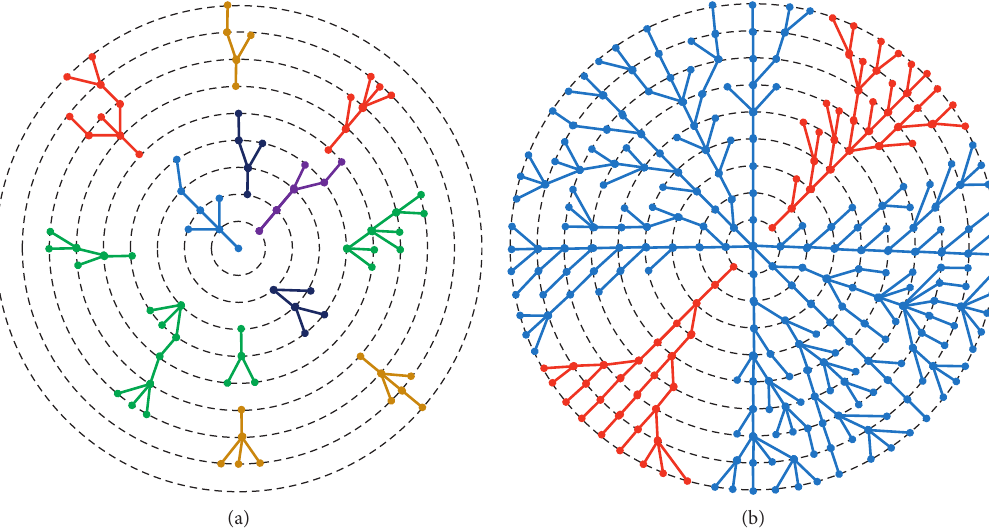
Figure 7: Hierarchical organizational structure of Twitter retweet distribution, corresponding to chaotic and ordered phases. (a) Subcritical phase. (b) Supercritical